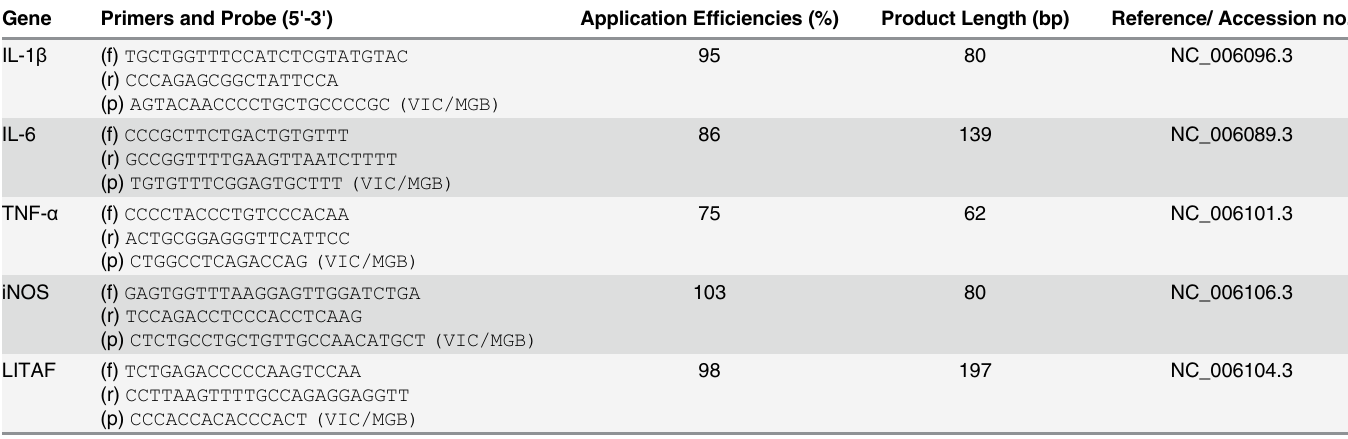
Table 1. Taqman primers and probes